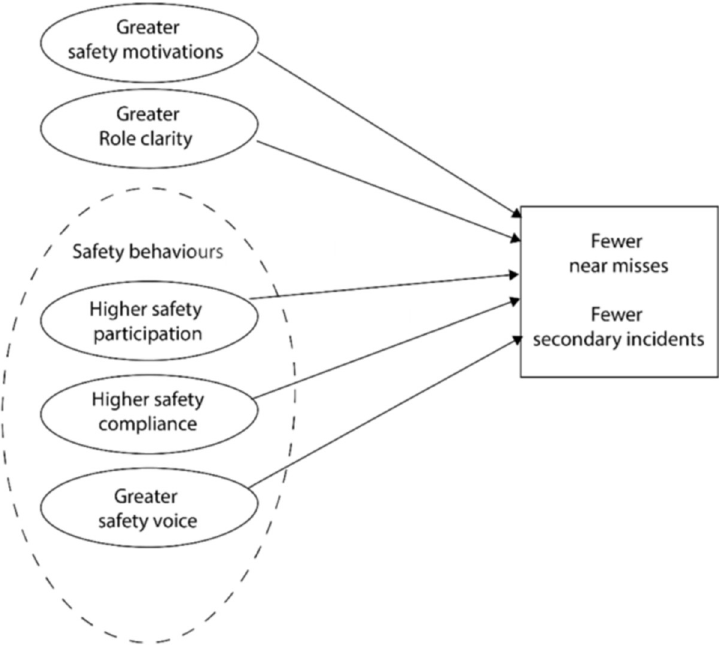
Fig 1. Hypothesised relationships between safety behaviours, motivation, role clarity and safety outcomes.